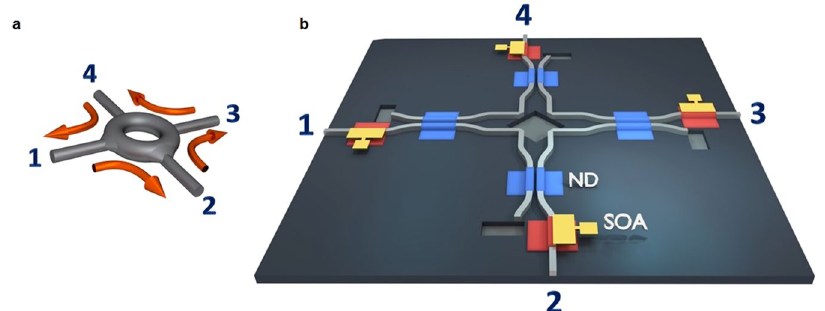
Figure 1. Unidirectional optical information transport arrangements. ( a ) Conceptually, light is unidirectionally directed between ports in such a re-routing device. ( b ) Schematic view of a magnet-free 4-port optical re-router used in this study. Signals in this active nonlinear system propagate in a counter-clockwise fashion. The gain (SOA) elements as well as the nonlinear decoupling (ND) segments are also